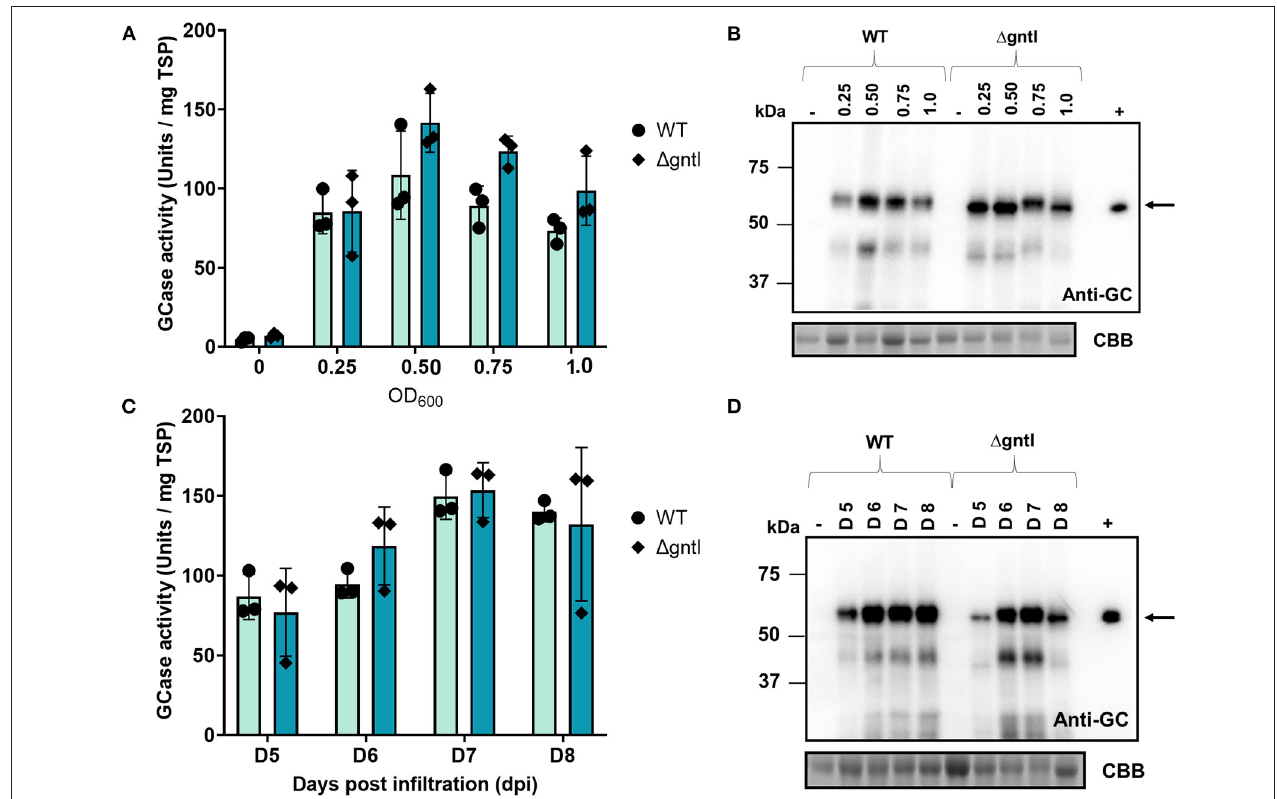
FIGURE 2 | Optimization of GCase transient production. GCase activity of crude protein from wild-type (WT) and 1 gntI leaves infiltrated with (A) different OD 600 values and (C) different days post-infiltration. Total soluble proteins: 5 and 10 µ g were loaded and analyzed using anti-GCase antibody and CBB staining, respectively (B,D) . Error bars represent the standard deviation (SD). The experiment was performed in three replications. (-), negative control from non-infiltrated leaves; ( + ), Cerezyme ® ; WT, wild-type N. benthamiana ; 1 gntI, glycoengineered N. benthamiana